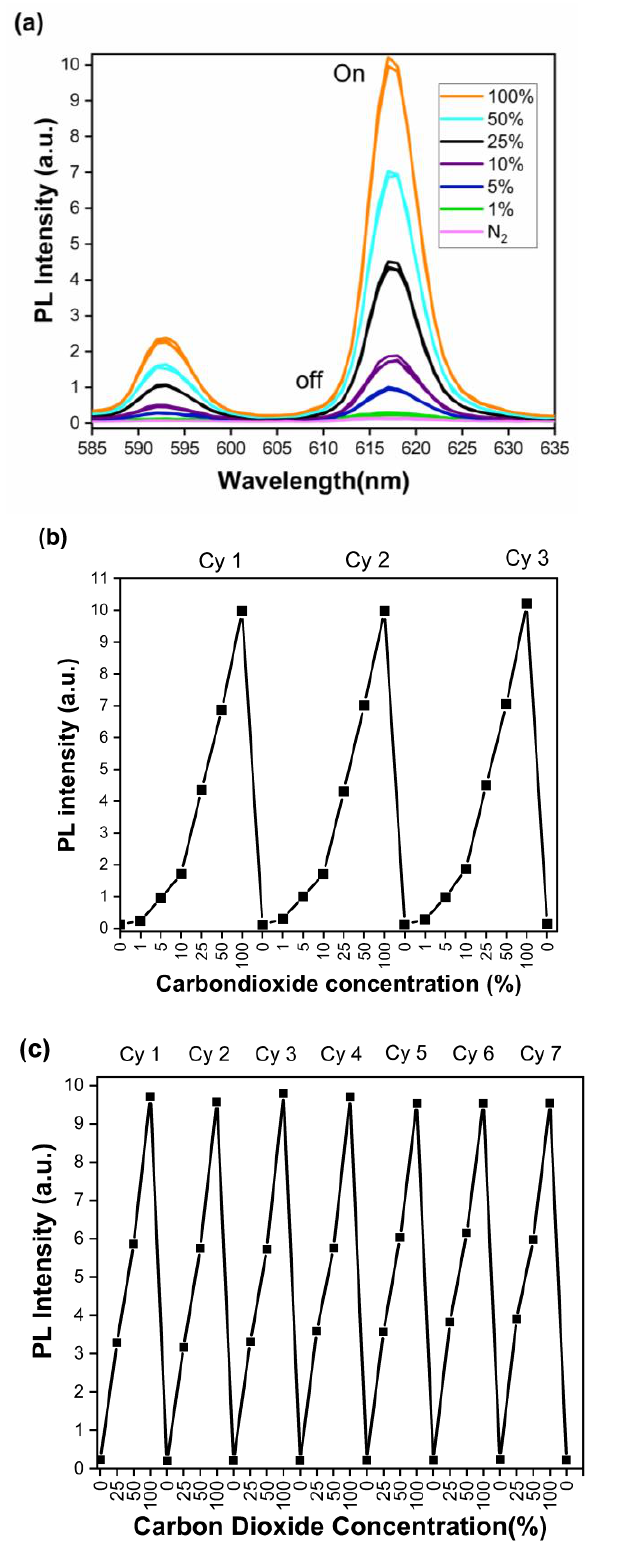
Figure 5. ( a ) PL spectra of the sensor after exposure to 1%, 5%, 10%, 25%, 50%, and 100% of CO 2 in N 2 . ( b ) PL peak intensity changes for three purging cycles using 1%, 5%, 10%, 25%, 50%, and 100% of CO 2 in N 2 . ( c ) PL peak intensity changes for seven purging cycles using 25%, 50%, and 100% of CO 2 in N 2 .